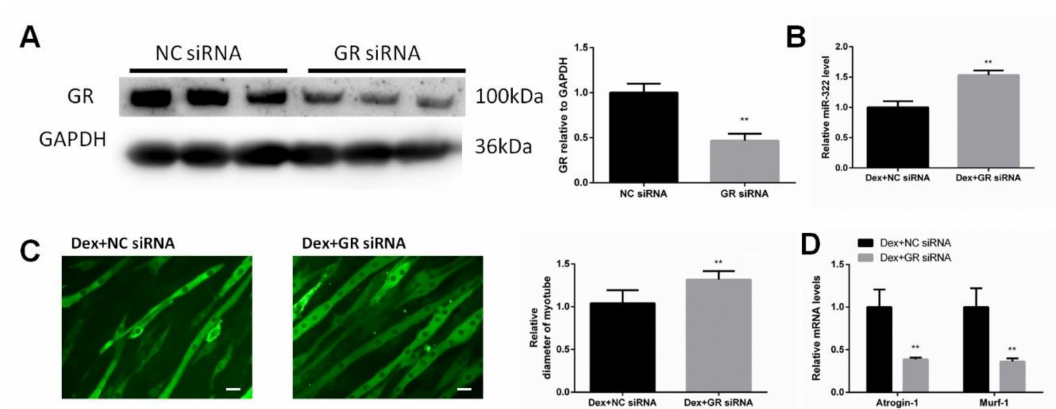
Figure 2. Glucocorticoid receptor ( GR ) negatively regulates miR-322 atrophy in C2C12 myotubes. ( A ) Western blot analysis showed that GR siRNA decreased the GR expression in Dex-induced C2C12 myotubes. ( B ) qRT-PCR analysis revealed the increased miR-322 expression when the C2C12 myotubes were transfected with GR siRNA. ( C ) Immunofluorescent staining C2C12 myotubes showed the decreased myotube diameter after transfection with GR siRNA. ( D ) qRT-PCR analysis revealed the increased Atrogin-1 and MuRF-1 expression levels when the C2C12 myotubes were transfected with GR